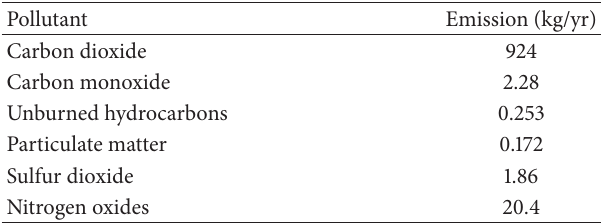
Table 6: Diesel systems green-house gases emission.